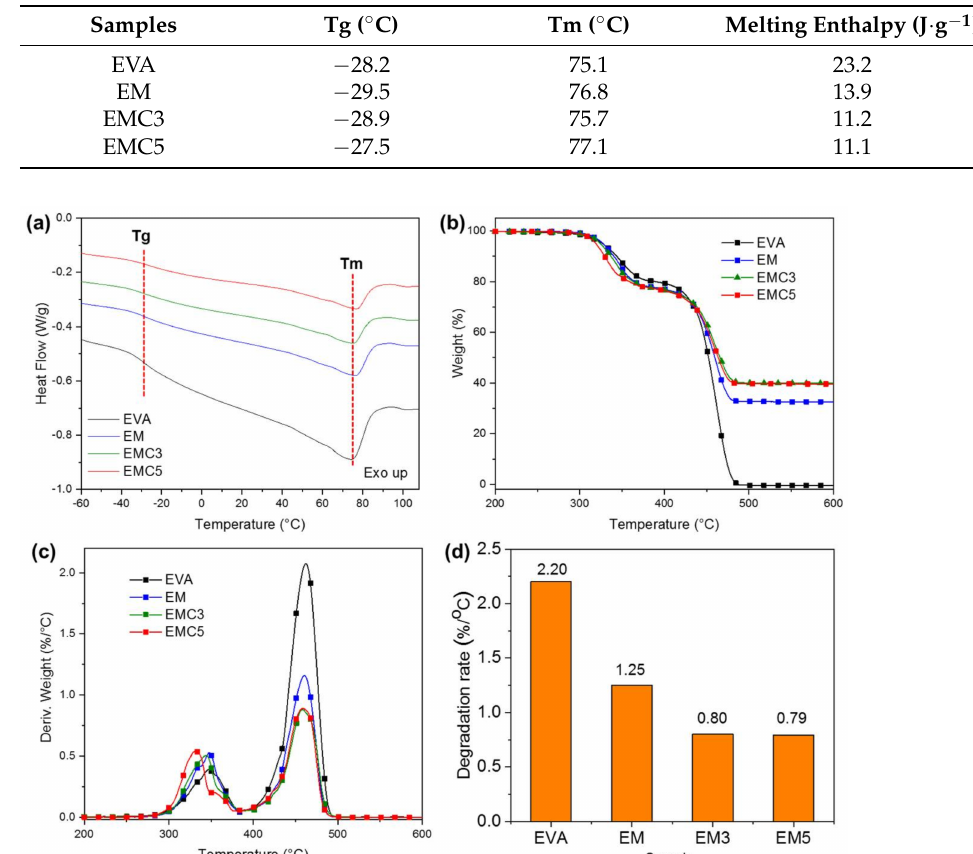
Figure 4. ( a ) DSC curves of the pure EVA, EM, EMC3, and EMC5 composites, ( b ) TGA curves, ( c ) DTGA curves and ( d ) the maximum thermal decomposition rate of the pure EVA, EM, EMC3, and EMC5